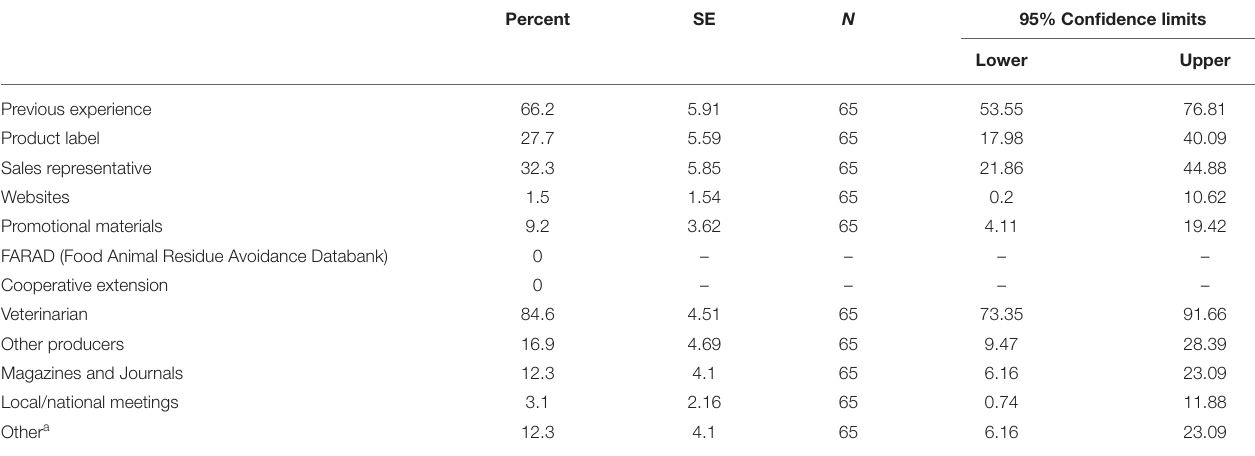
TABLE 9 | Information sources for antimicrobial drugs used to treat preweaned calves on California dairies.